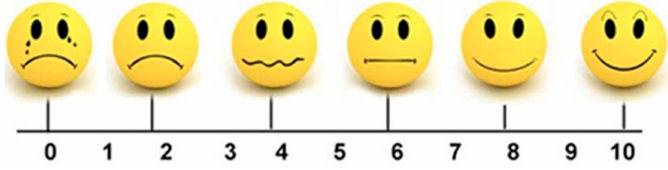
Figure 1. Emoji scale used in